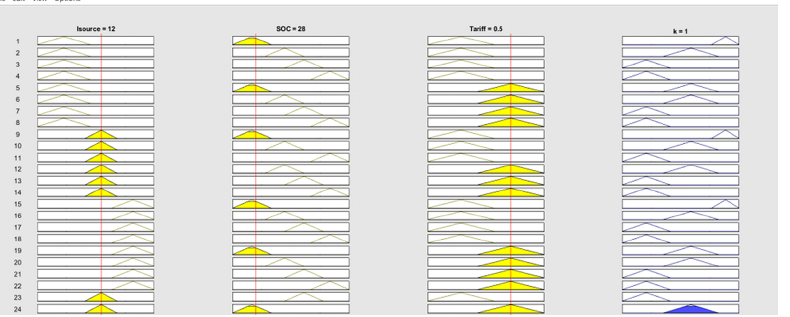
Figure 10. Rule viewer with medium source current, SoC very low, and high grid tariff with K = k2.